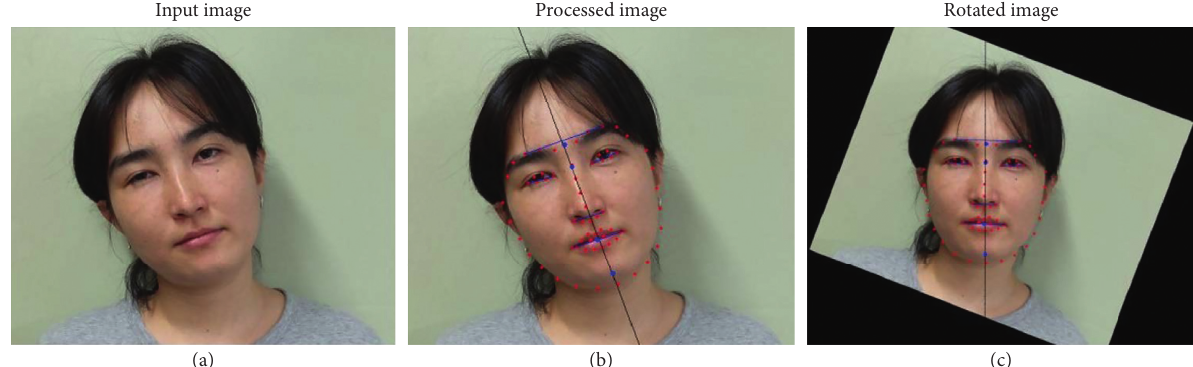
Figure 1: Automated analysis of facial asymmetry indices using computer-aided detection. (a) The original frontal face photograph is uploaded in the software. (b) The system automatically detects facial features of the eyes, nose, mouth, and facial outlines defined by 68 landmark points using the active appearance model (AAM). The degree of face tilt ( ° ) is calculated by the angle of the line that passes between the landmark points of the facial midline (black line) in reference to the vertical line (angle of inclination 90 ° ). (c) Rotation of the image is automatically processed according to the degree of face tilt.